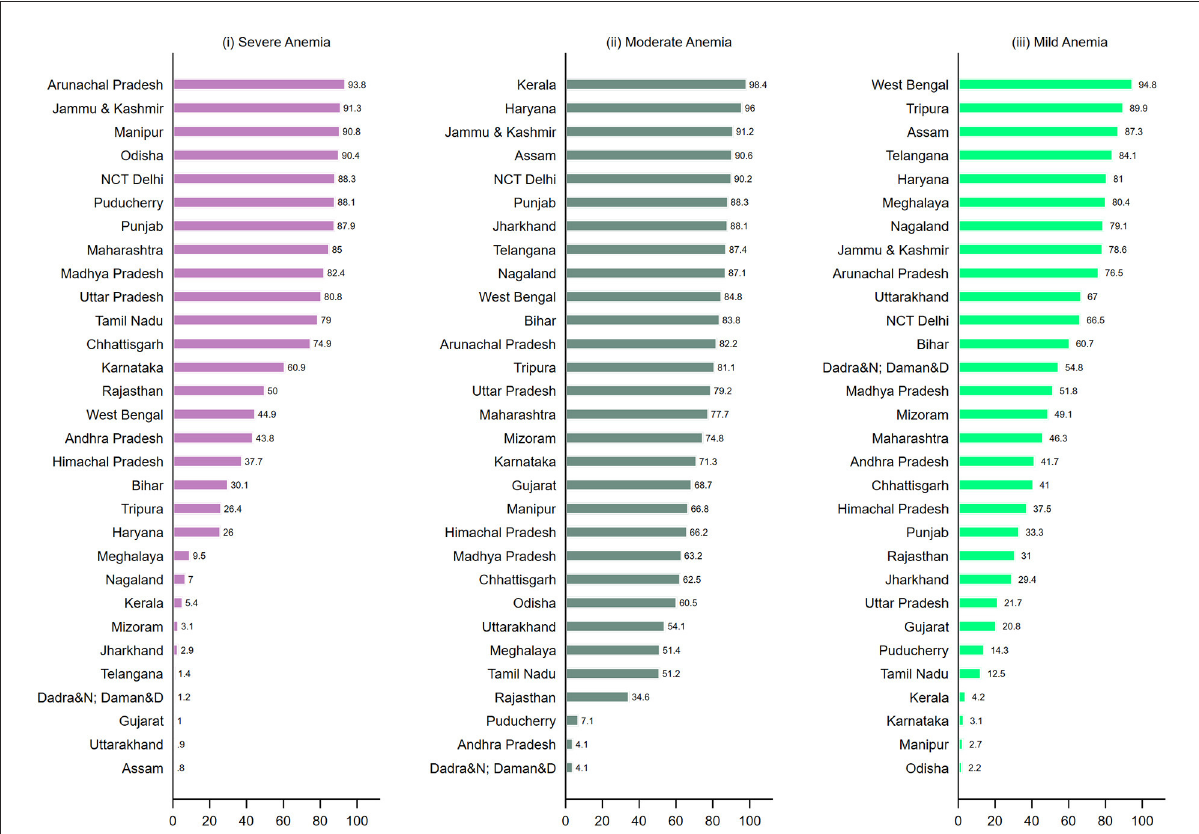
FIGURE4 Geographic variation of (i) Severe anemia; (ii) Moderate anemia; (iii) Mild anemia among children (6–59 months) attributable to small areas (clusters) (%) across states and Union Territories in India, NFHS,